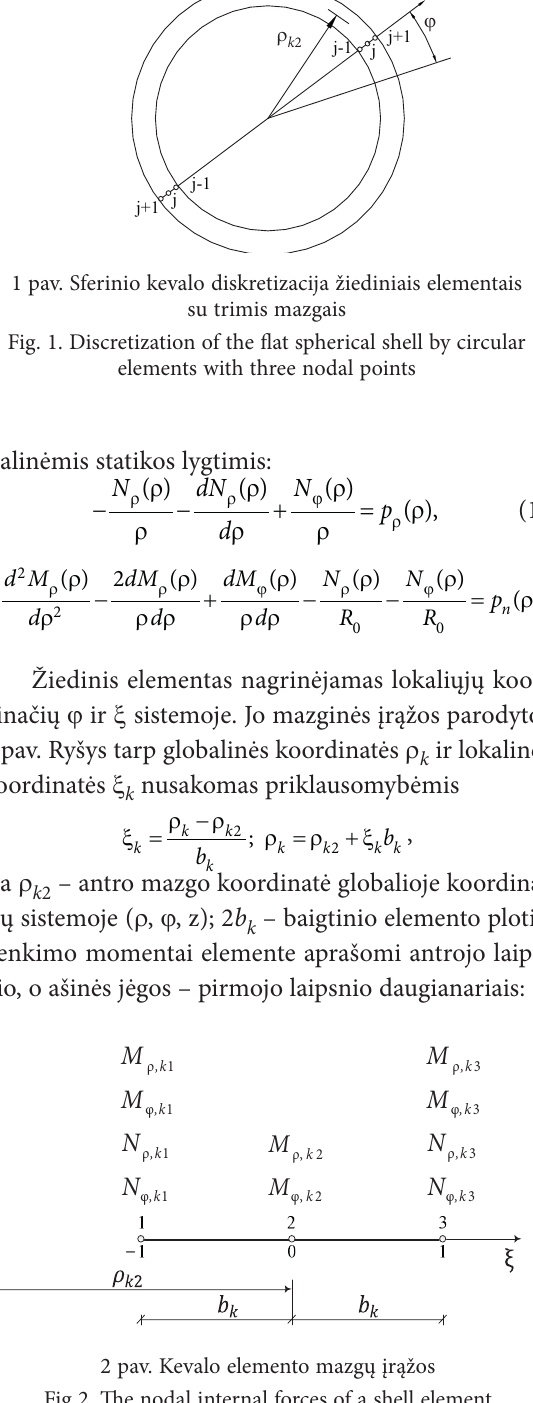
Fig 2. The nodal internal forces of a shell